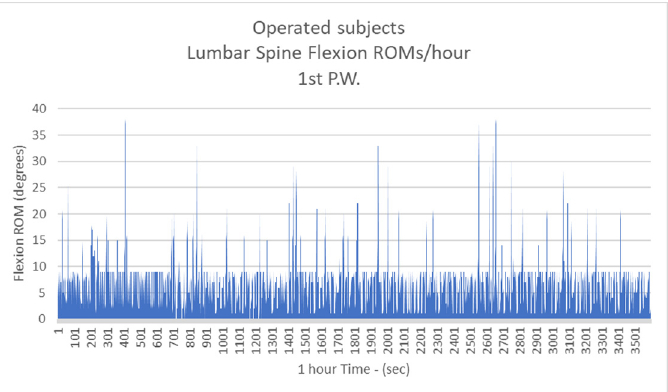
Figure 5. The number of more than 10 degrees of Lumbar Spine Flexions (LSFs) per hour for operated subjects at the 1st postoperative week.